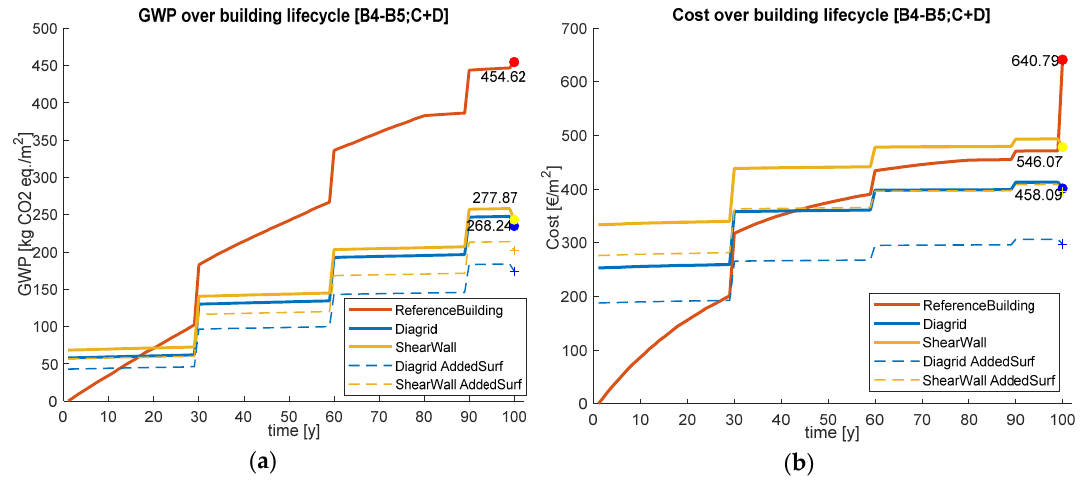
Future scenarios depending on the building quality: ( a ) GWP and ( b ) cost over building lifecycle.